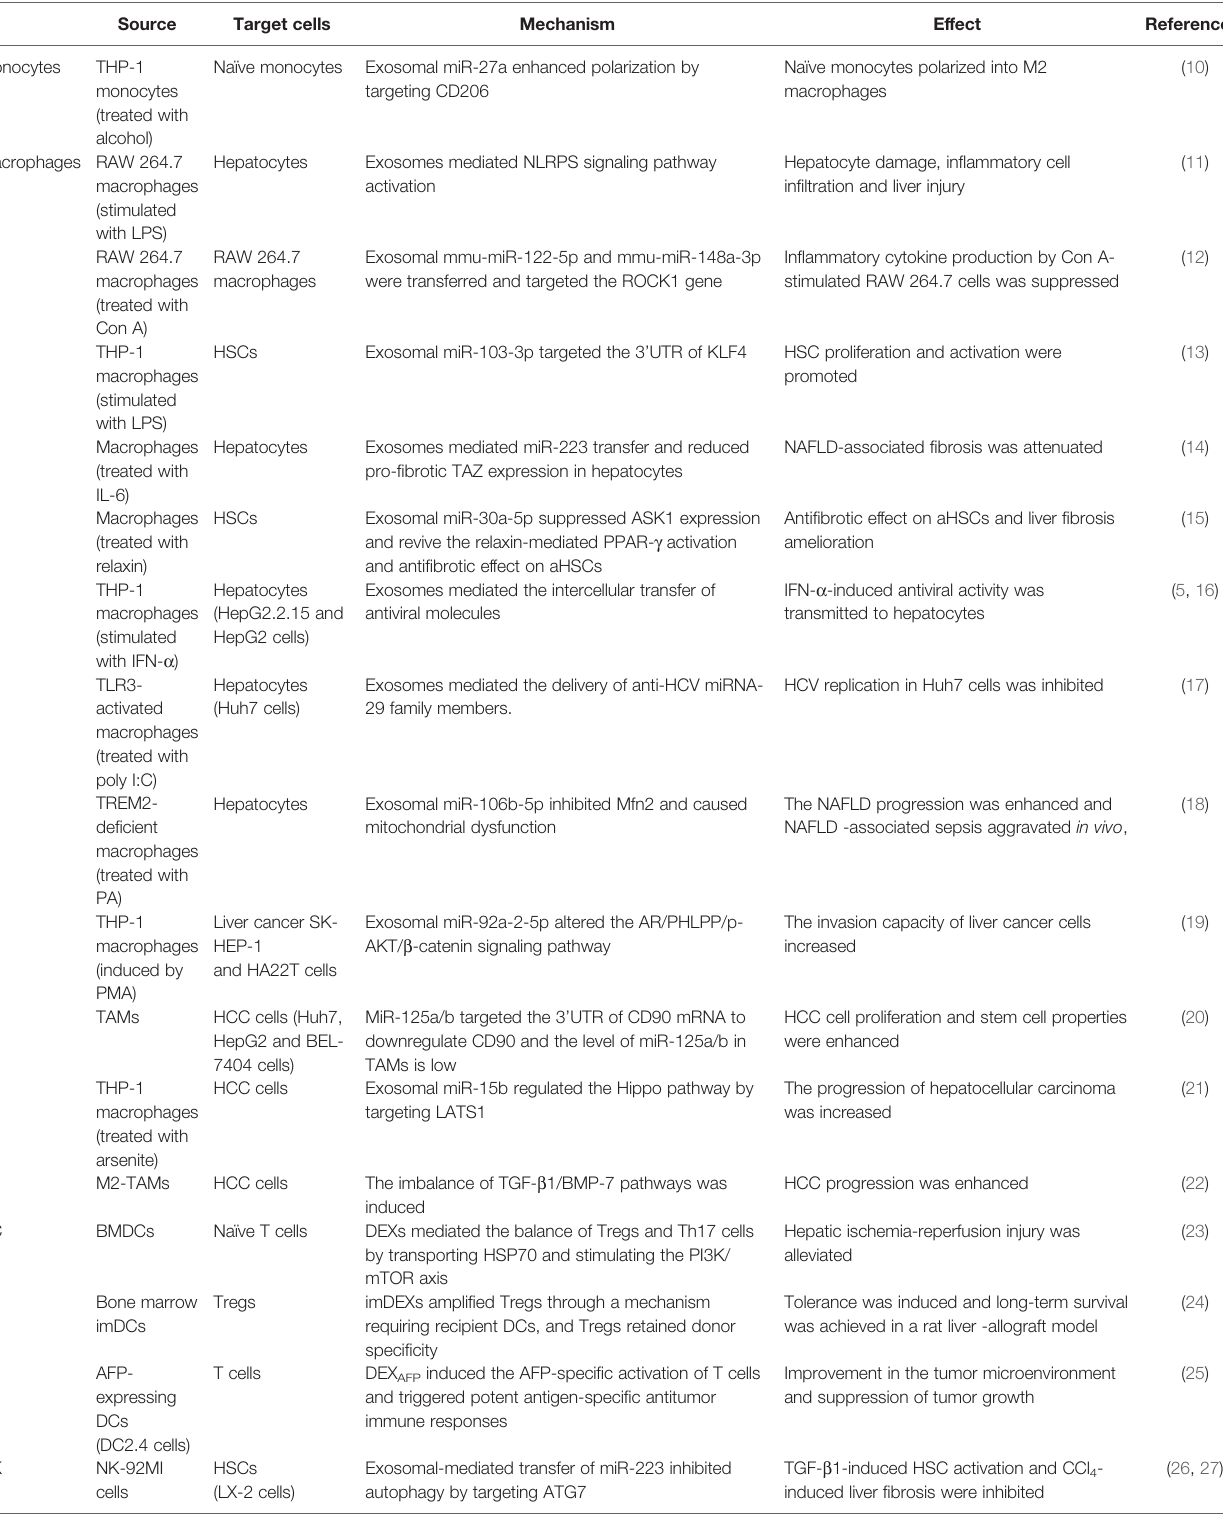
TABLE 1 | Summary of the effects of exosomes derived from immune cells on liver